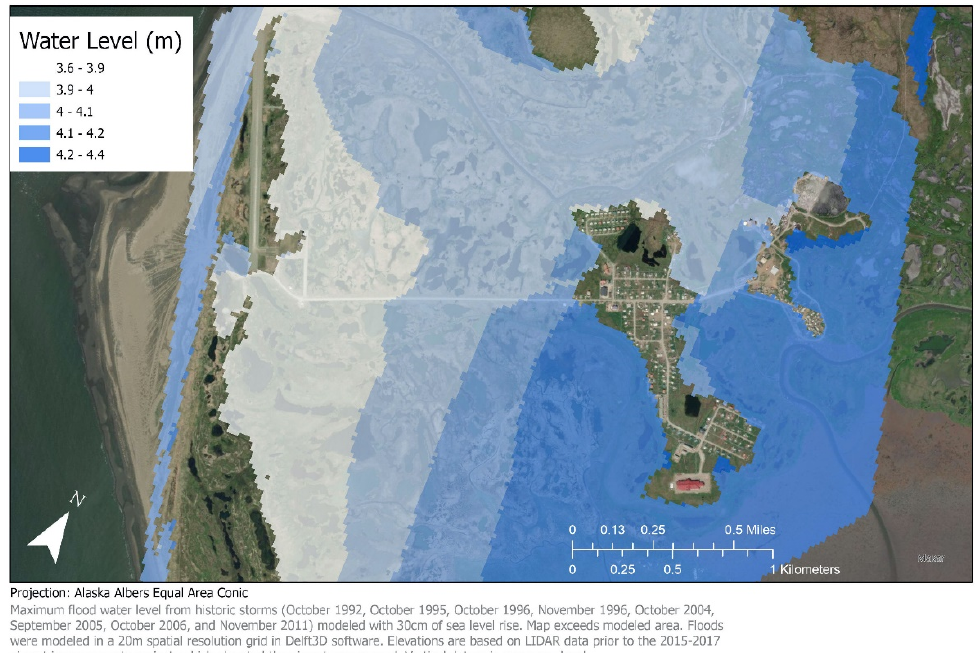
Figure 11. Maximum water level for the storms with a 30 cm SLR applied.